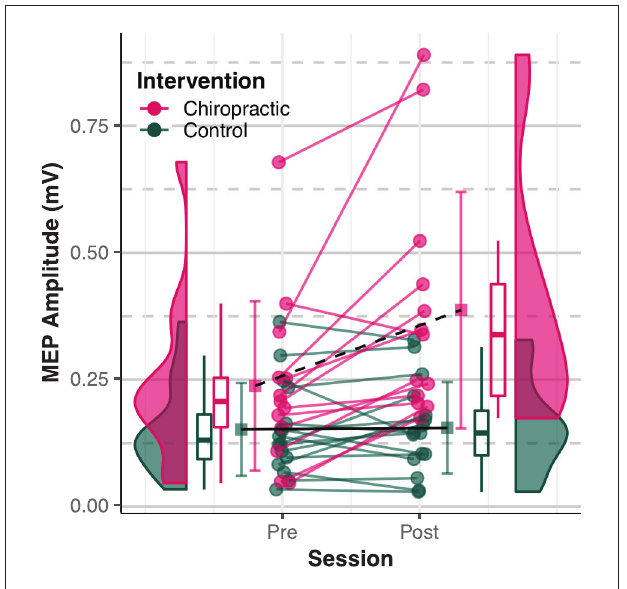
FIGURE 1 | Motor Evoked Potentials (MEPs) amplitude. Dots represent individual MEP amplitudes. Boxplots show the median, 25th, and 75th percentiles. Error bars represent mean ± SD. The distribution plots show the density distribution estimated by a Gaussian kernel with an SD of 1.5. The chiropractic manipulation resulted in a larger MEP amplitude (dashed black line) compared to the control intervention (solid black line). The figure is inspired by raincloud plots (